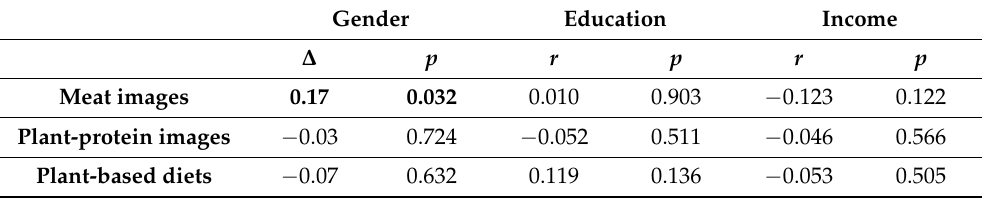
Table 5. Changes in expected taste according to gender, education level, and income. For gender, ∆ indicates change in females—change in nonfemales; thus, positive numbers indicate greater changes in nonfemales, based on paired t -tests. Pearson correlations values between changes in expected taste and education and income are also shown. Bold values indicate p <